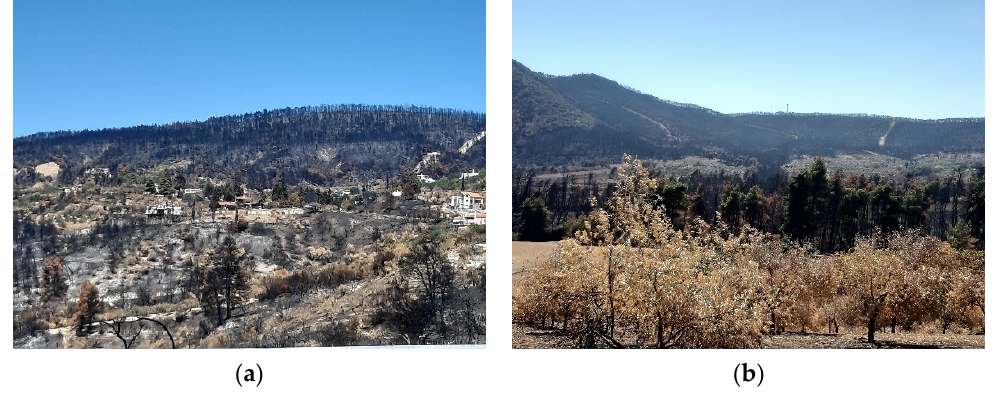
Figure 15. Evolution of clustering of fire front, thermal detection, and daily burnt area.